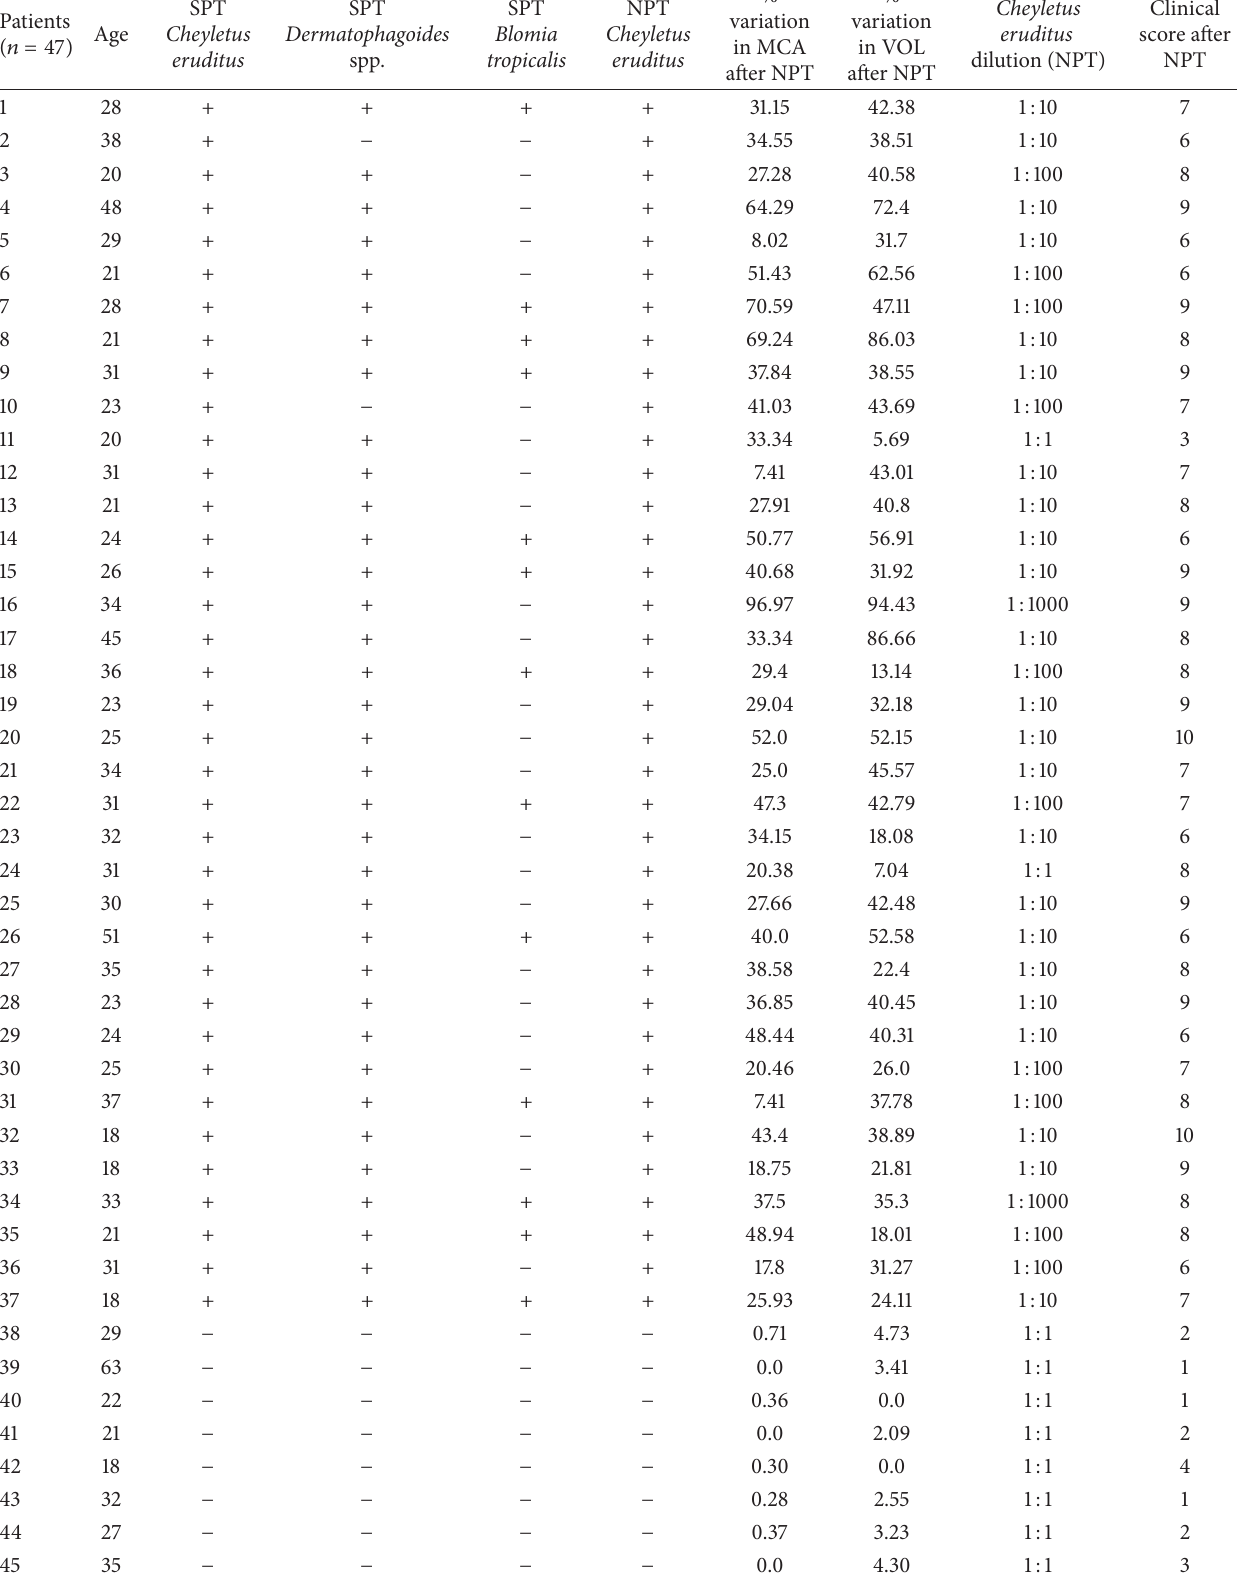
Table 1: Patient data and specific nasal provocation test with Cheyletus eruditus